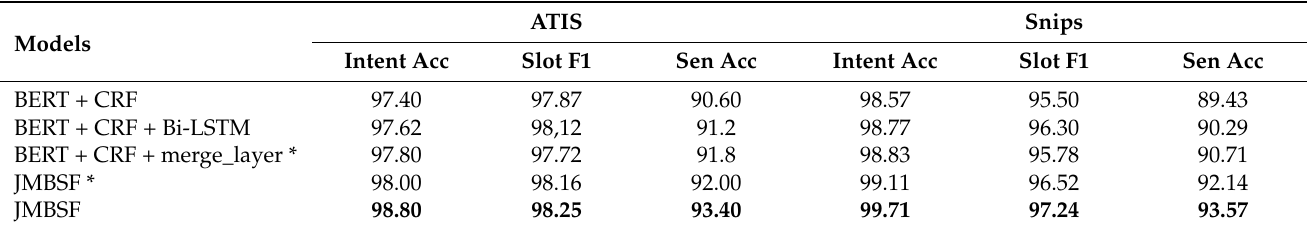
Table 4. Comparison of ablated model structures between ATIS and Snips datasets %.